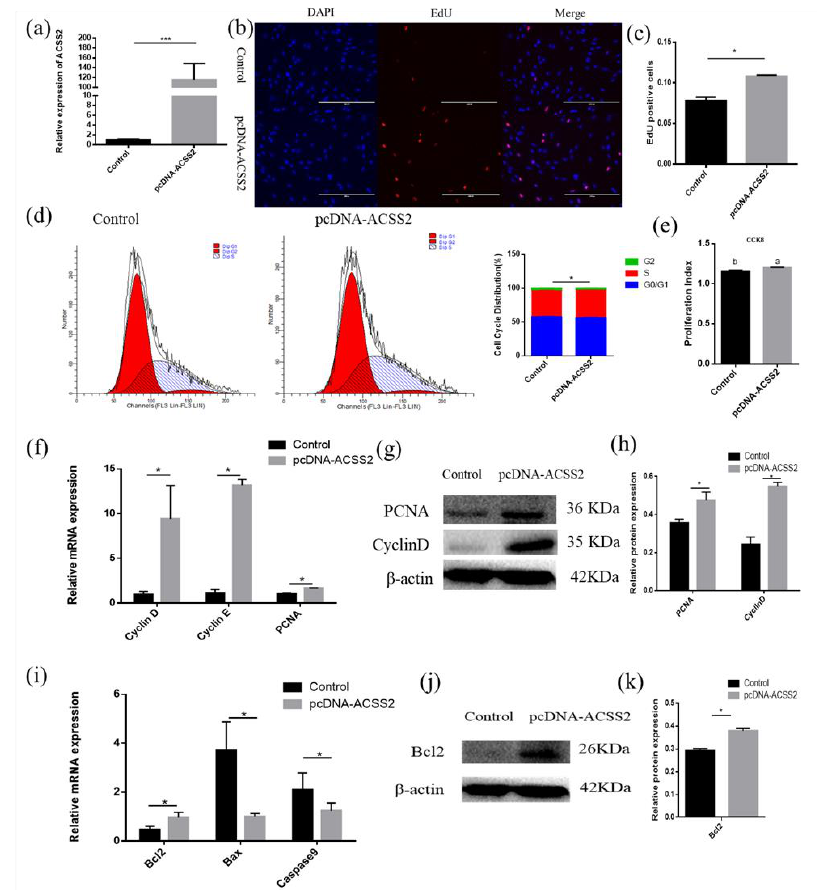
Figure Figure 6. ACSS2 promotes adipose cells proliferation and inhibits adipose cells apoptosis.